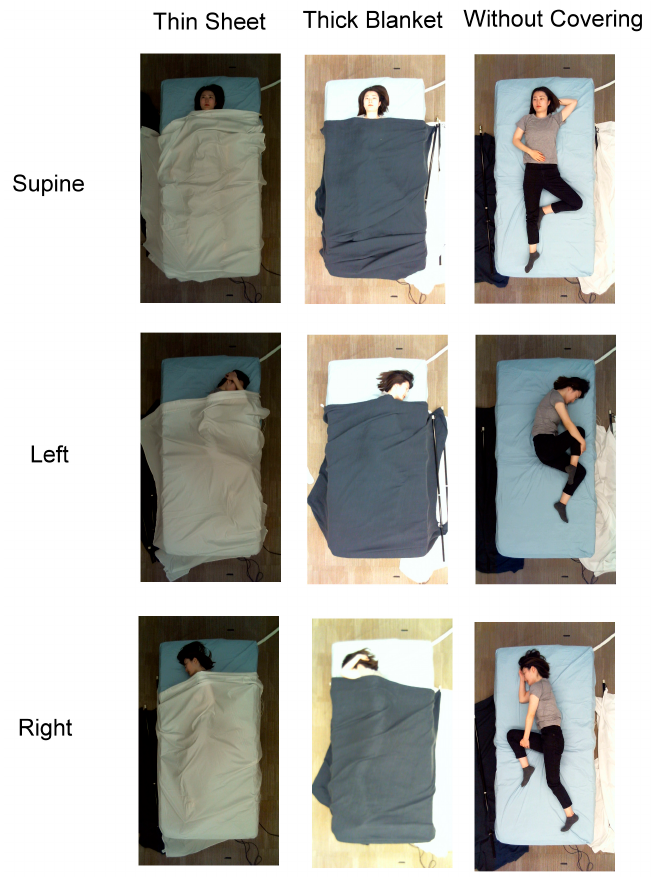
Figure 3. Sample images for each pose class from the SLP database [42].